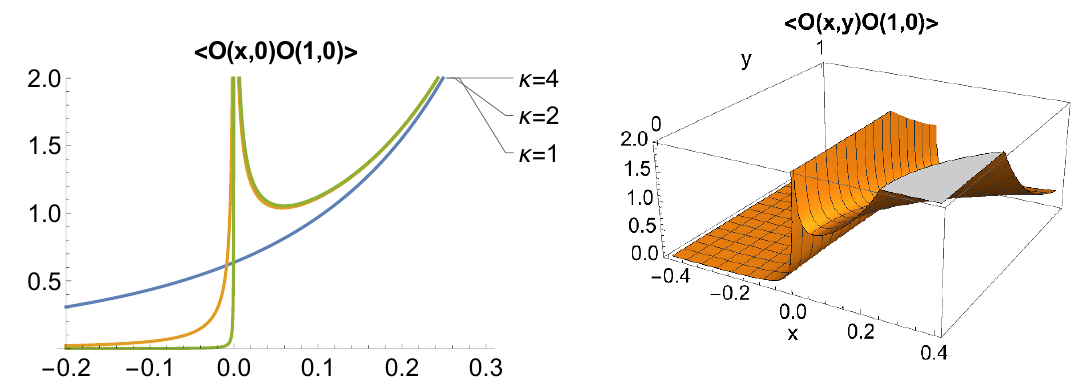
Figure 3 . Plot of hO ( x; 0) O (1 ; 0) i for (cid:20) = 1 ; 2 ; 4 and (cid:1) = 2 (left) and plot of hO ( x; y ) O (1 ; 0) i for (cid:20) = 2 and (cid:1) = 2